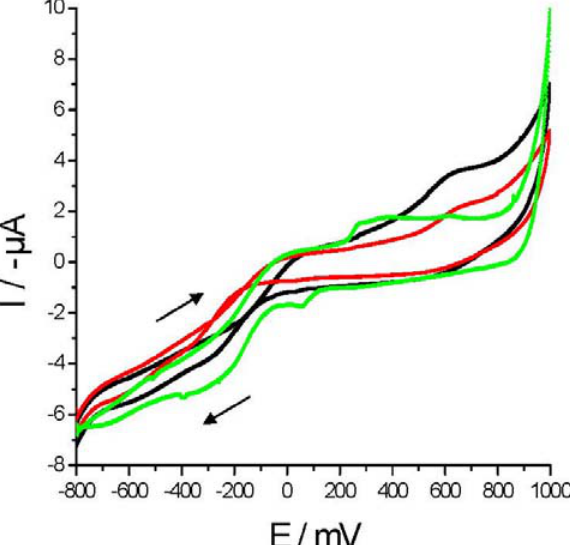
Figure 3. Cyclic voltammetries performed with Au WE over melamine adulterated and non-adulterated milk samples. M (black curve); MSM (red curve). Melamine concentrations were 8.5 g·L − 1 ( MSM melamine. The scan direction is indicated by a black